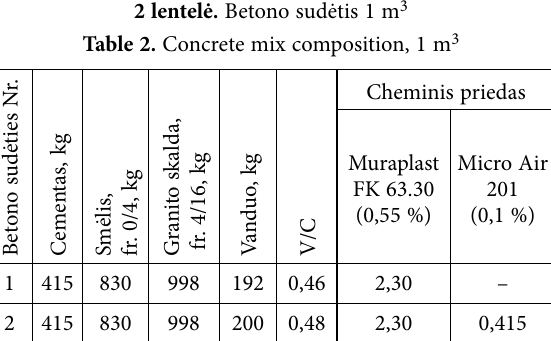
Table 2. Concrete mix composition, 1 m 3